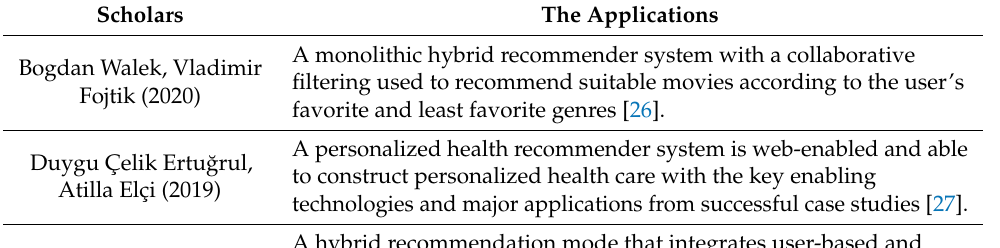
Table 1. The applications on recommendation systems.